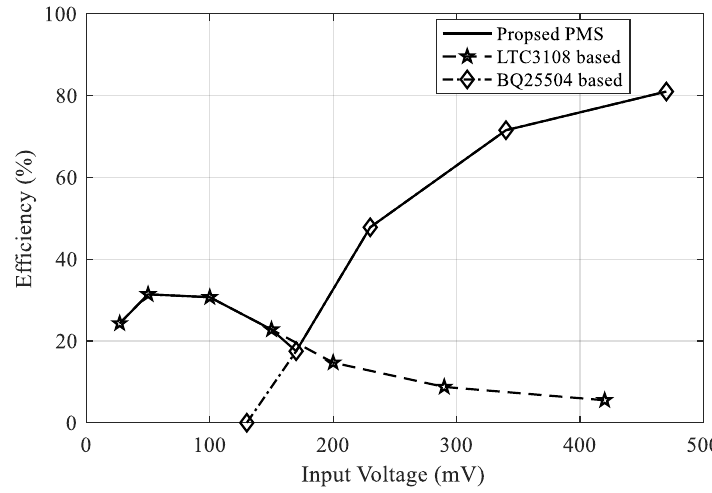
Figure 11. Working efficiency of the proposed PMS.